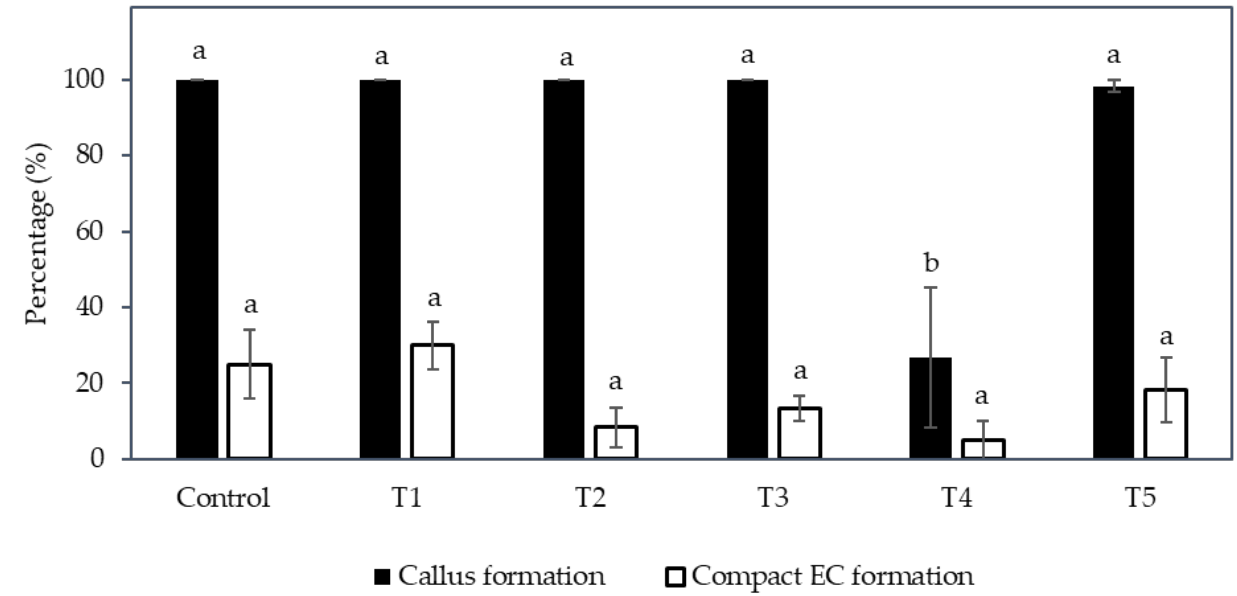
Figure 6. The effect of various combinations of nitrate and ammonium ion concentrations placed into the Y3 medium with and without amino acids (Control, T1 to T5; see table in Section 4.6) on the percentage of callus and compact embryogenic callus formation. Each bar represents the mean ± standard error; n = 5. Bars covered by the same letter were not significantly different (Tukey’s test, p ≤ 0.05).